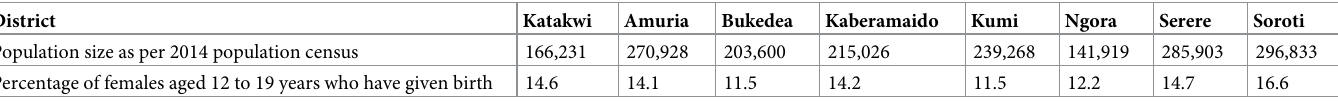
Table 1. Showing previous child bearing rates among adolescent females in various districts of Teso region. District Katakwi Amuria Bukedea Kaberamaido Kumi Ngora Serere Soroti Population size as per 2014 population census 166,231 270,928 203,600 215,026 239,268 141,919 285,903 296,833 Percentage of females aged 12 to 19 years who have given